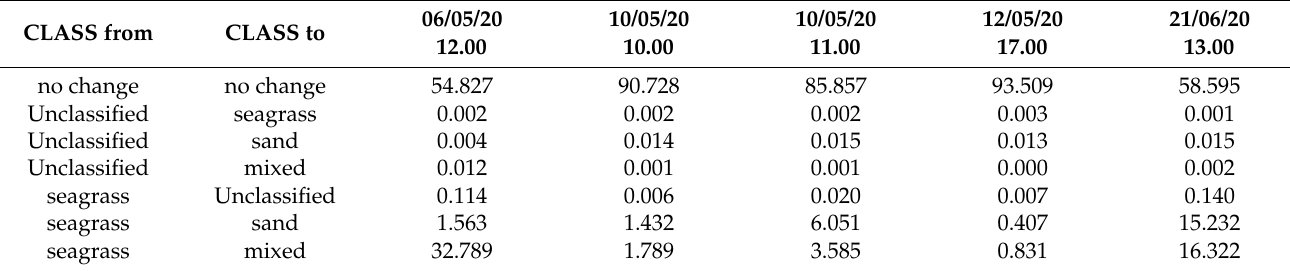
Table A3. Percentage changes from class to class calculated by the change detection